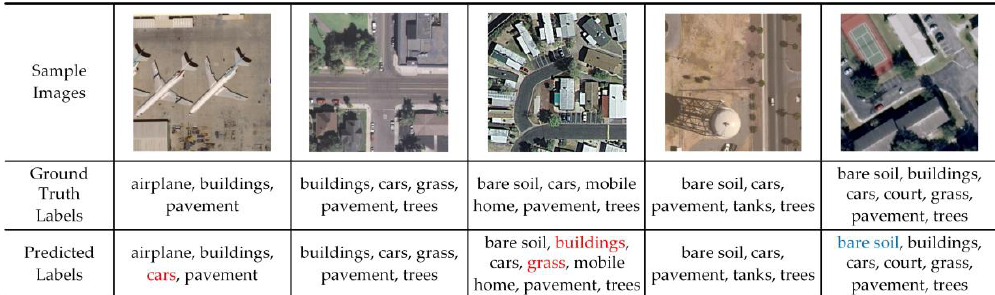
Figure 4. Sample images and predicted labels in the UCM multi-label dataset. Red predictions indicate the false positives (FP), and blue predictions indicate the false negatives (FN).